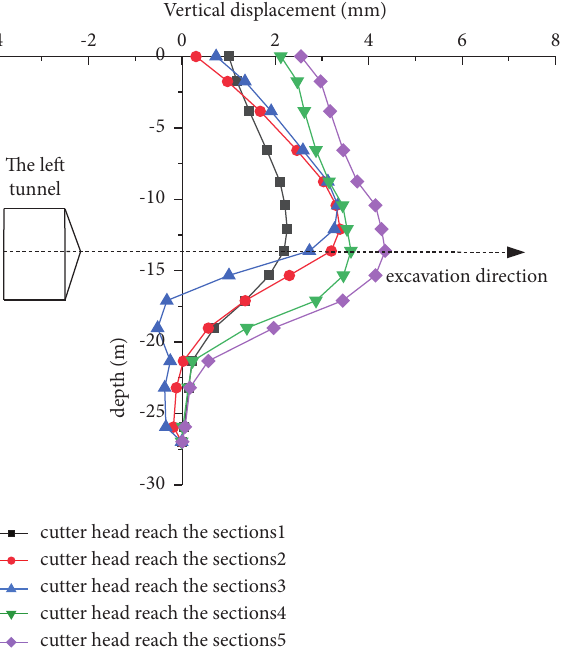
Figure 24: The left tunnel excavation gap is not filled.